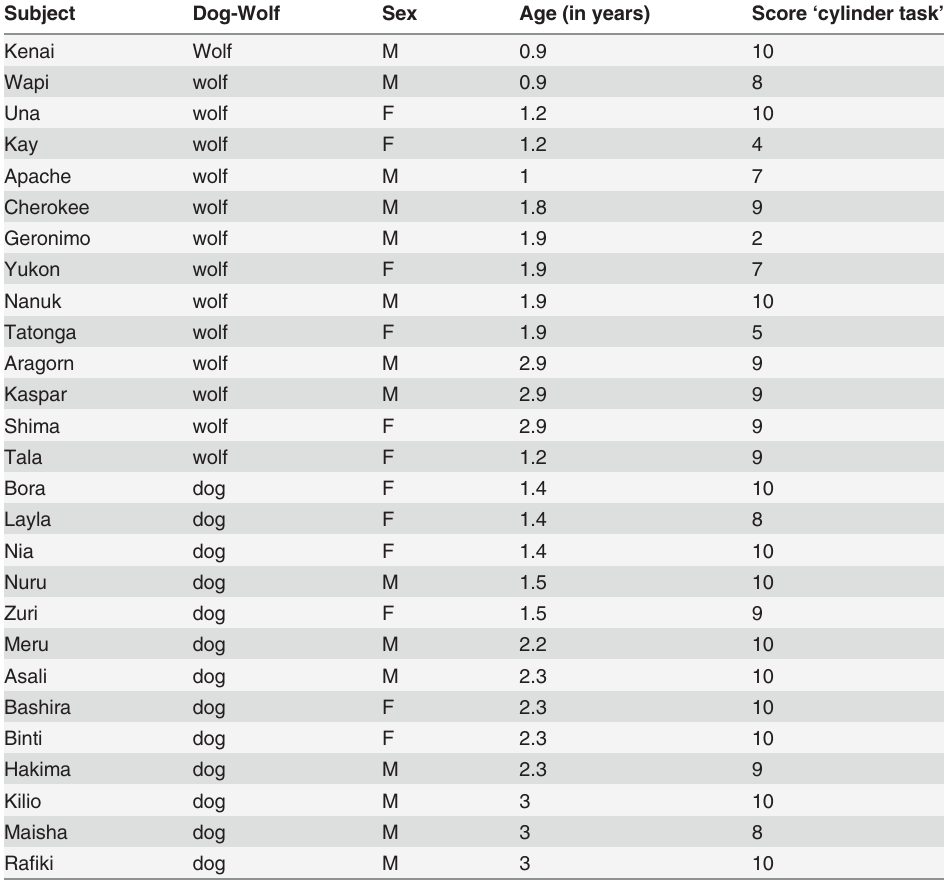
Table 2. Test scores (correct out of 10) in the cylinder task, sex and age of wolves and dogs tested at the